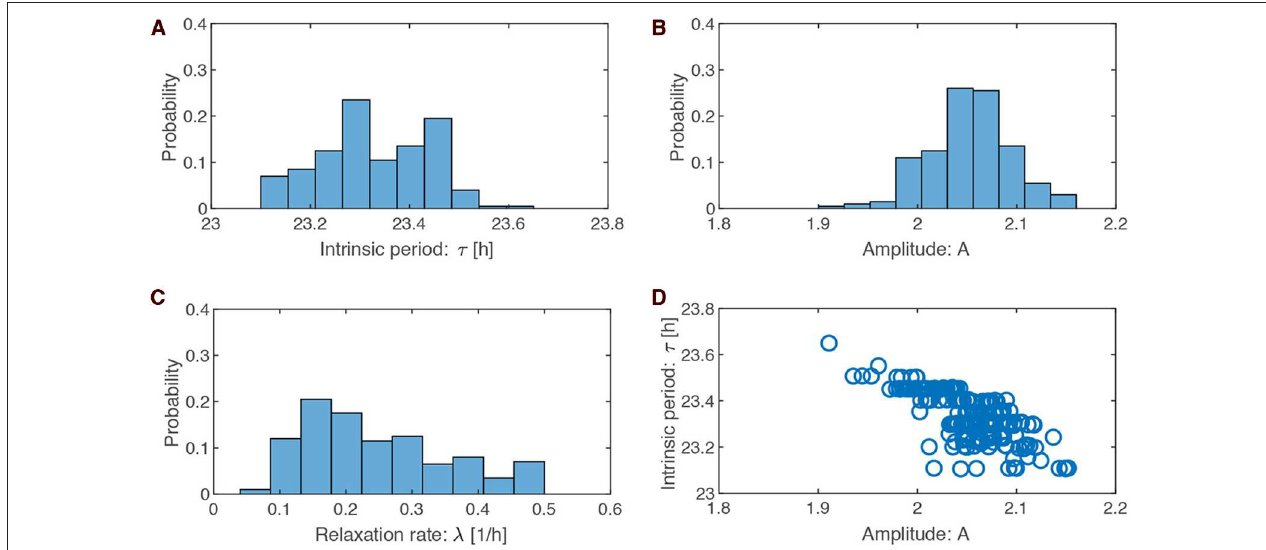
FIGURE 3 | Parameter values in the optimized ensemble. (A–C) Distributions of the optimized parameter values for intrinsic period τ ( = 2 π/ω ), oscillation amplitude A , and relaxation rate λ , respectively. (D) Scatter plots of amplitude A against intrinsic period τ drawn for the 200 sets of optimized parameters.